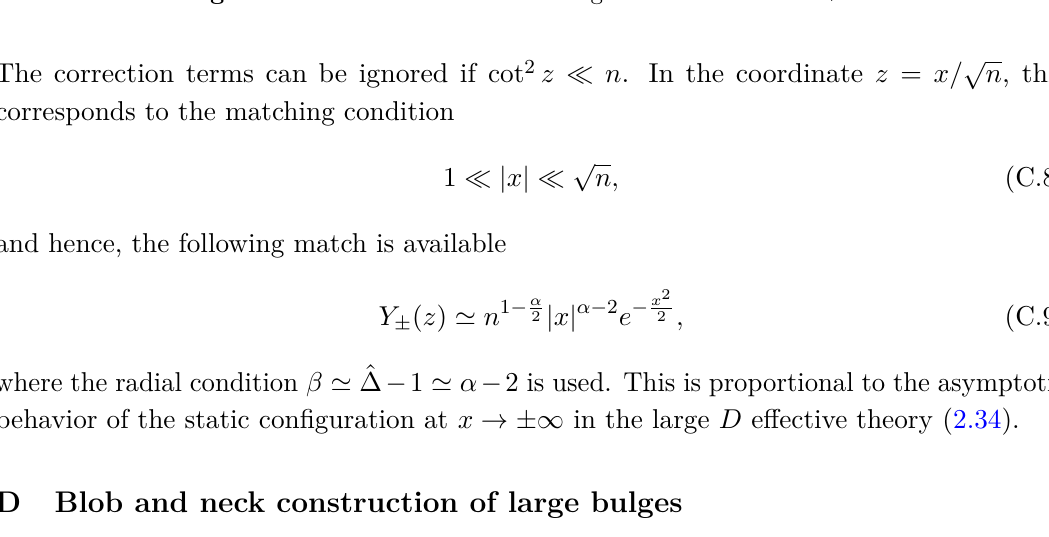
Figure 11 . Blob and kink in the bulge solution for α = 1 + 2 ε